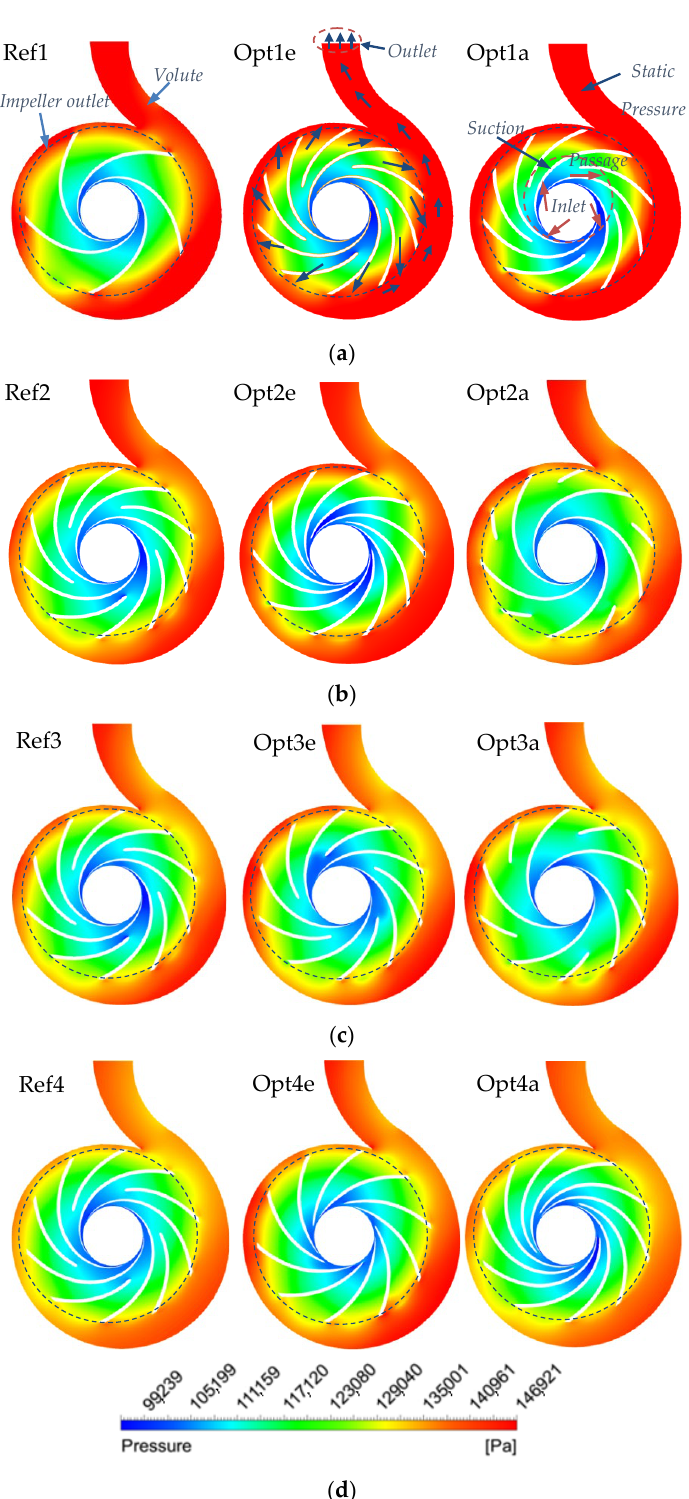
Figure 20. Static pressure contours at the midspan of the reference and optimized impeller for all cases: ( a ) water, ( b ) C1, ( c ) C2, and ( d )